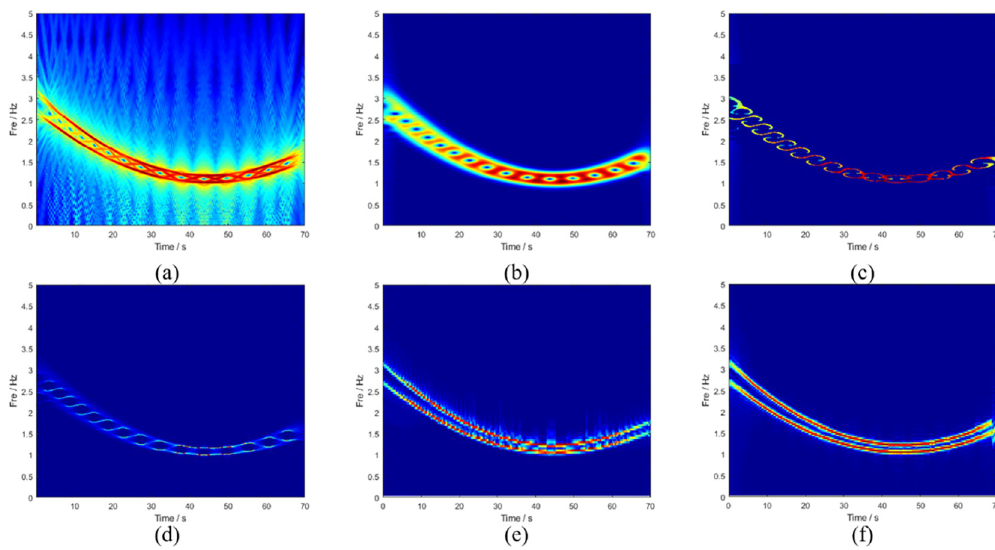
Fig 8. TFA results obtained through(a) GLCT,(b) STFT,(c) SET,(d) SST,(e) VSLCT, and (f) SBCT.